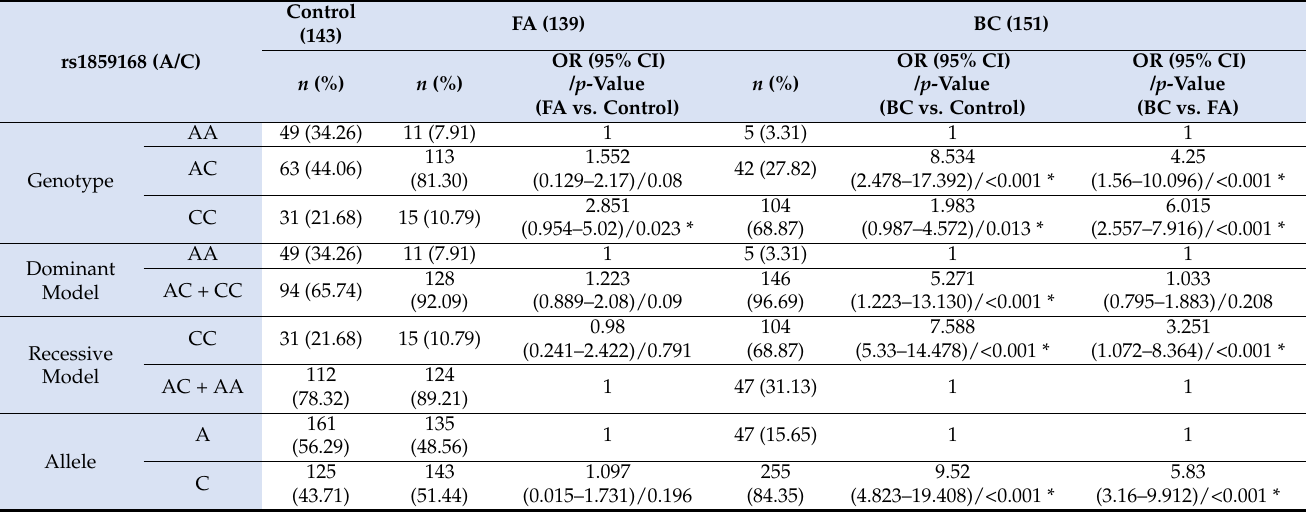
Table 2. Distribution frequency of the rs1859168 genotypes and alleles in patients with breast cancer, fibroadenoma, and healthy